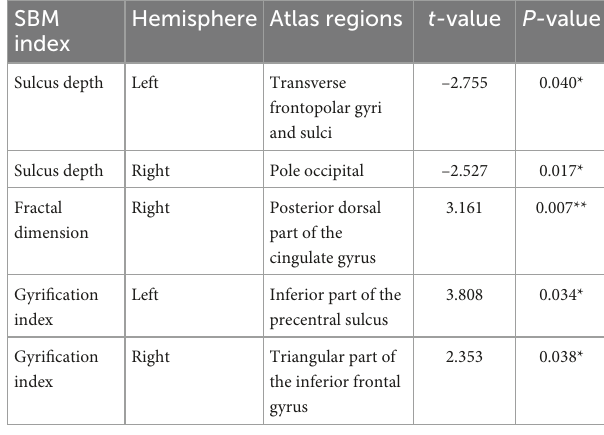
in SBM indices, gender was added as a covariate, and SPM software was used to perform factorial design, followed by two- sample t -tests with Holm-Bonferroni correction. The relationships between cognitive function scores, cytokines and SBM indices were calculated using Spearman partial correlation analysis controlled with gender. P < 0.05 was regarded as statistically significant.